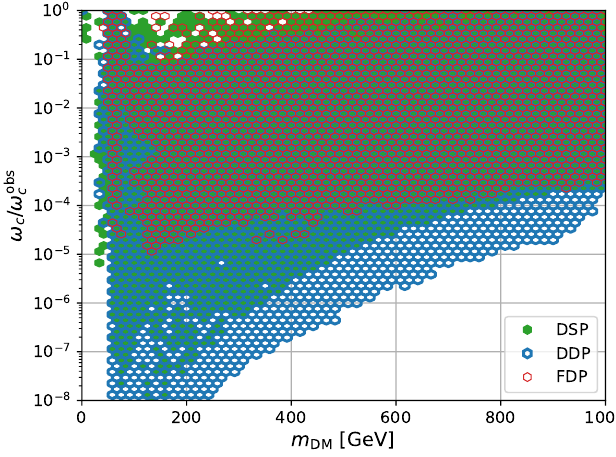
Figure 4 . Fraction of the DM relic density as a function of the DM mass for the three DM phases. For the FDP, we show the mass of the dark matter candidate that gives the largest contribution to the relic density.